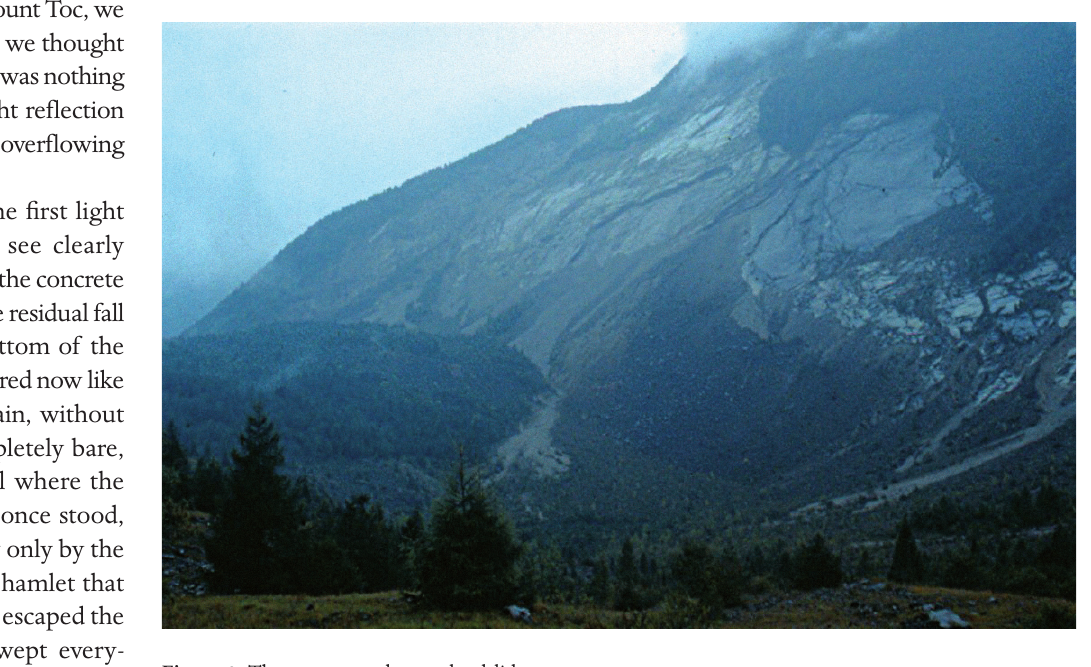
Figure 3. The present rock mass landslide.